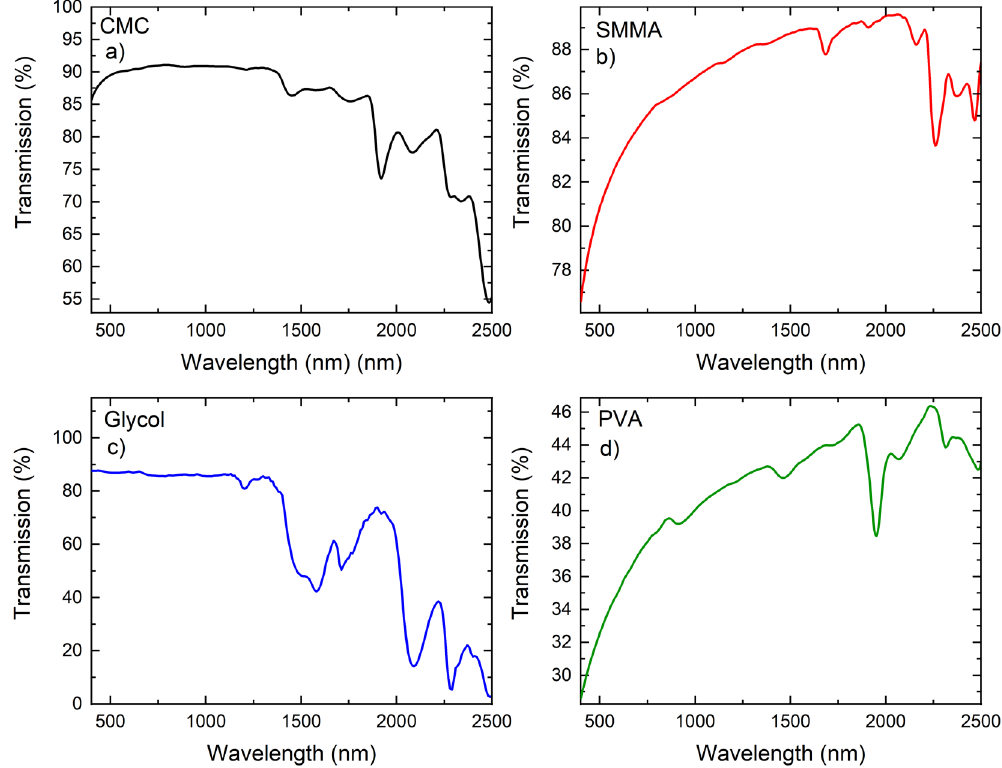
Figure 6. Transmissions of the samples used in the study. ( a ) CMC, ( b ) SMMA, ( c ) Glycol and ( d )